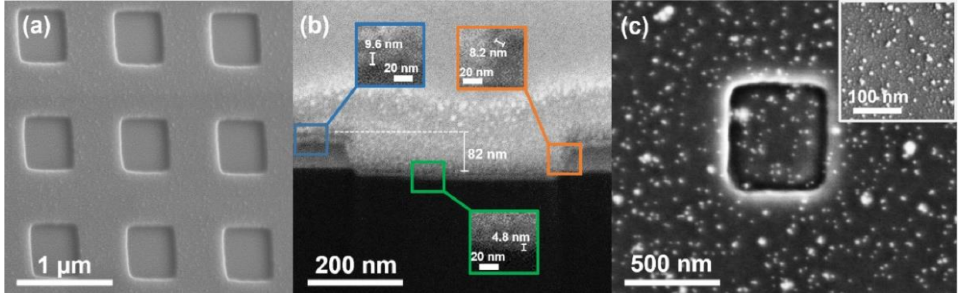
Figure 3. ( a ) Top-view and ( b ) cross-section SEM images of few-layer MoS 2 /Si NSHs. The inserted images are enlarged from the corresponding areas of the platform, lateral wall and basin. ( c ) Top-view SEM image of few-layer MoS 2 /Si NSHs after spreading Au NPs. The inset is the top view amplified SEM image of the platform